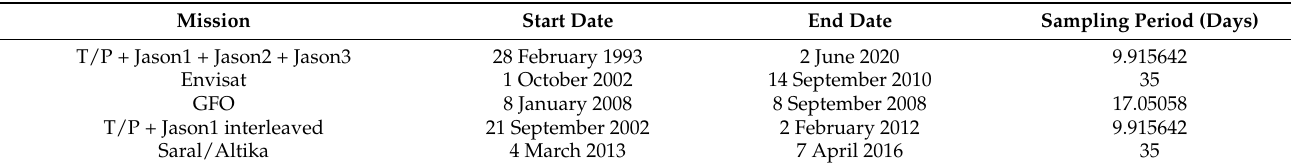
Table 2. Details for analyzed satellites in this research.